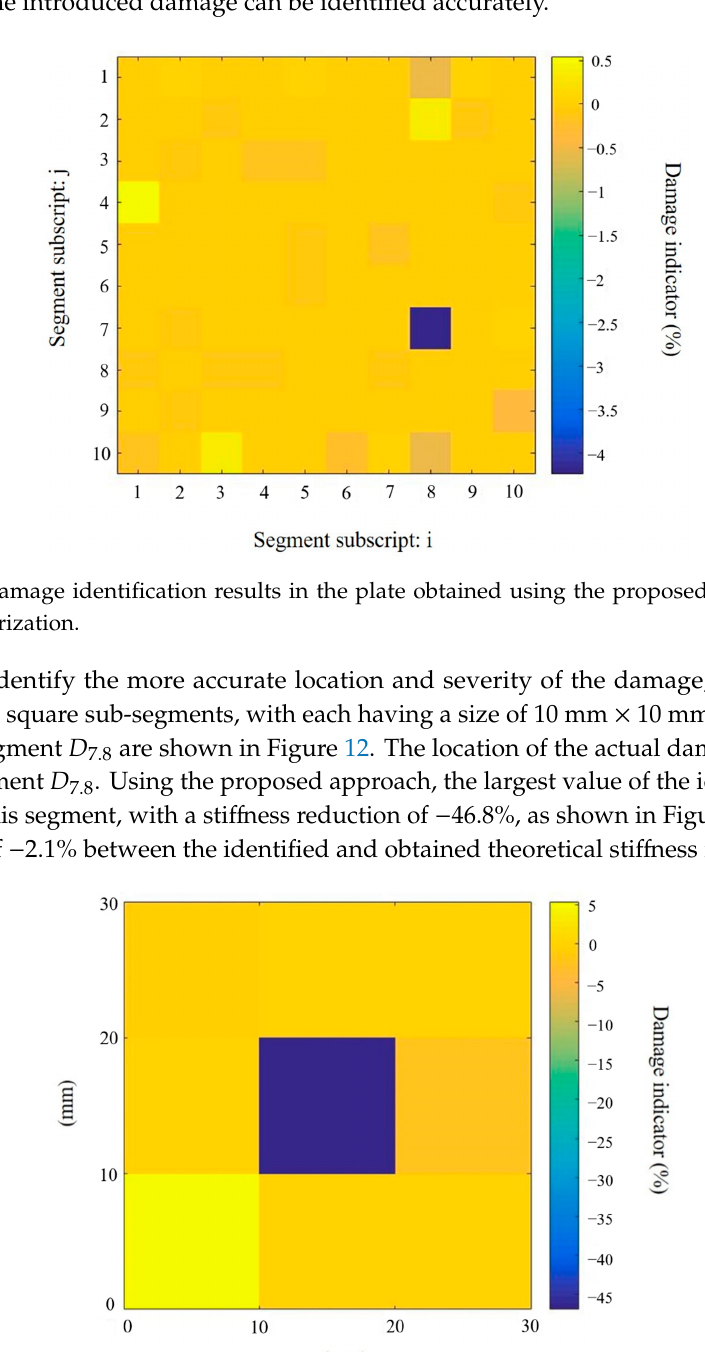
Figure 10. Damage identification results in the plate obtained using model updating with Tikhonov regularization method.